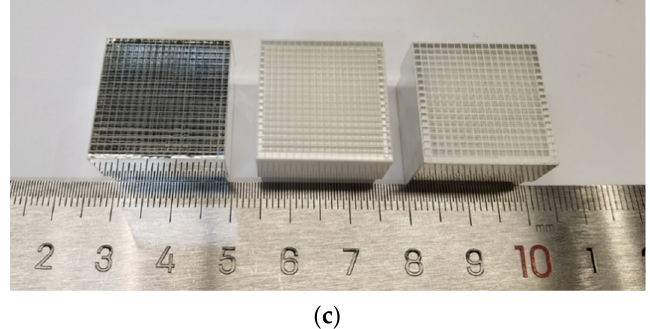
Figure 1. ( a ) A model of the dual-layer-offset crystal array. ( b ) A diagram of the relationship between the decoding spots and the crystal layers where the interactions occur. The decoding spots of the top crystals and the bottom crystals alternate. ( c ) A picture of the three crystal arrays constructed with three different reflectors: ESR, Toray, and BaSO 4 .